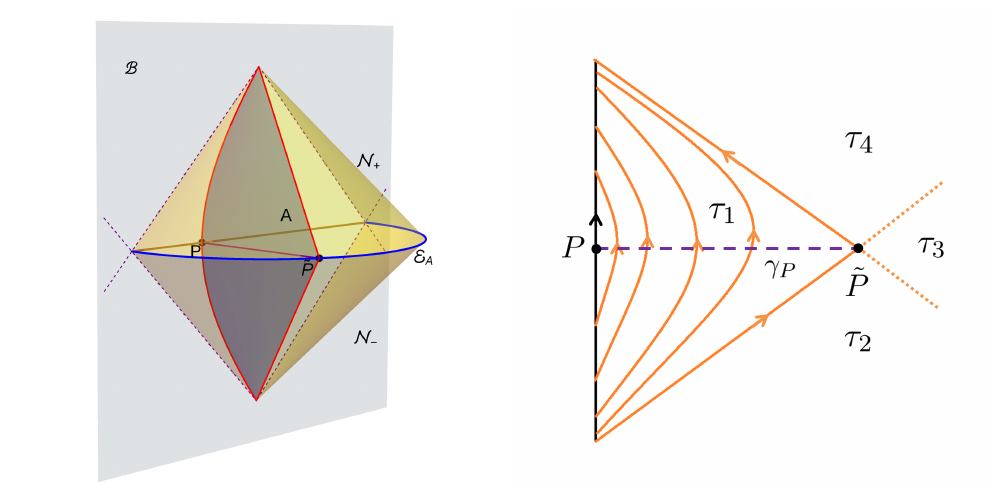
/ CFT Figure 2: A typical example of the modular slice in AdS . In the left figure, the 3 2 modular slice at the point P is embedded in the entanglement wedge. The right figure shows how the boundary modular flow curve flows in the bulk under the bulk mod- ular flow. The dashed curve γ is where is modular slice intersect with the homology P surface. τ denotes the modular flow in different causal wedges in the bulk. The m modular flow curves become null at the boundary of the entanglement wedge, and are just the null geodesic congruence emanating from the RT surface E vertically. A